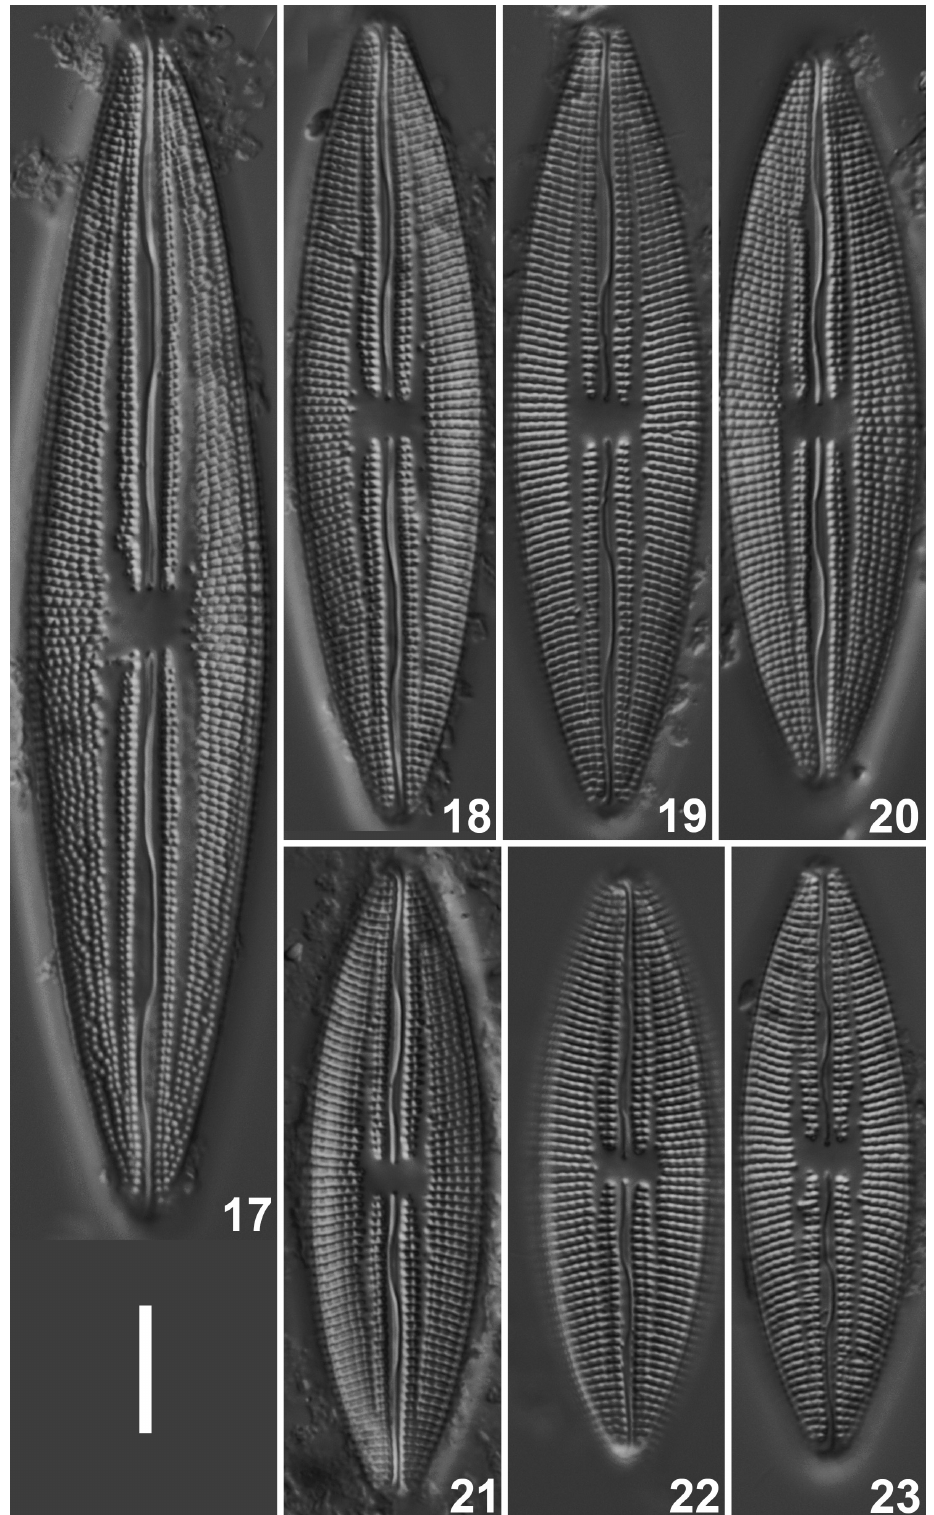
Figs 17–23. Mastogloia belaensis M.Voigt. Light micrographs (LM) of valves from the Lac de Guiers population ( Van de Vijver sample SEN-42 ). LM views of several specimens showing variation in valve size and shape. Scale bar: 10